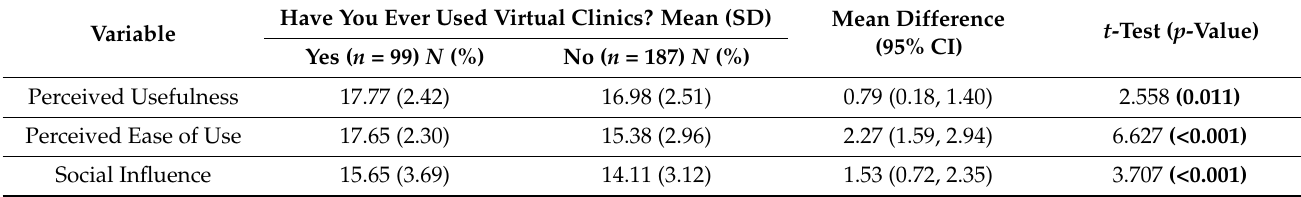
Table 4. TAM factors affecting virtual clinics ’ use.